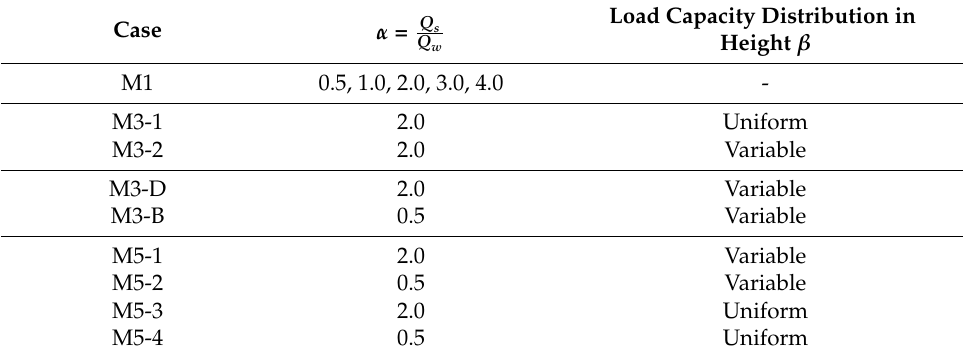
Table 3. Studied case